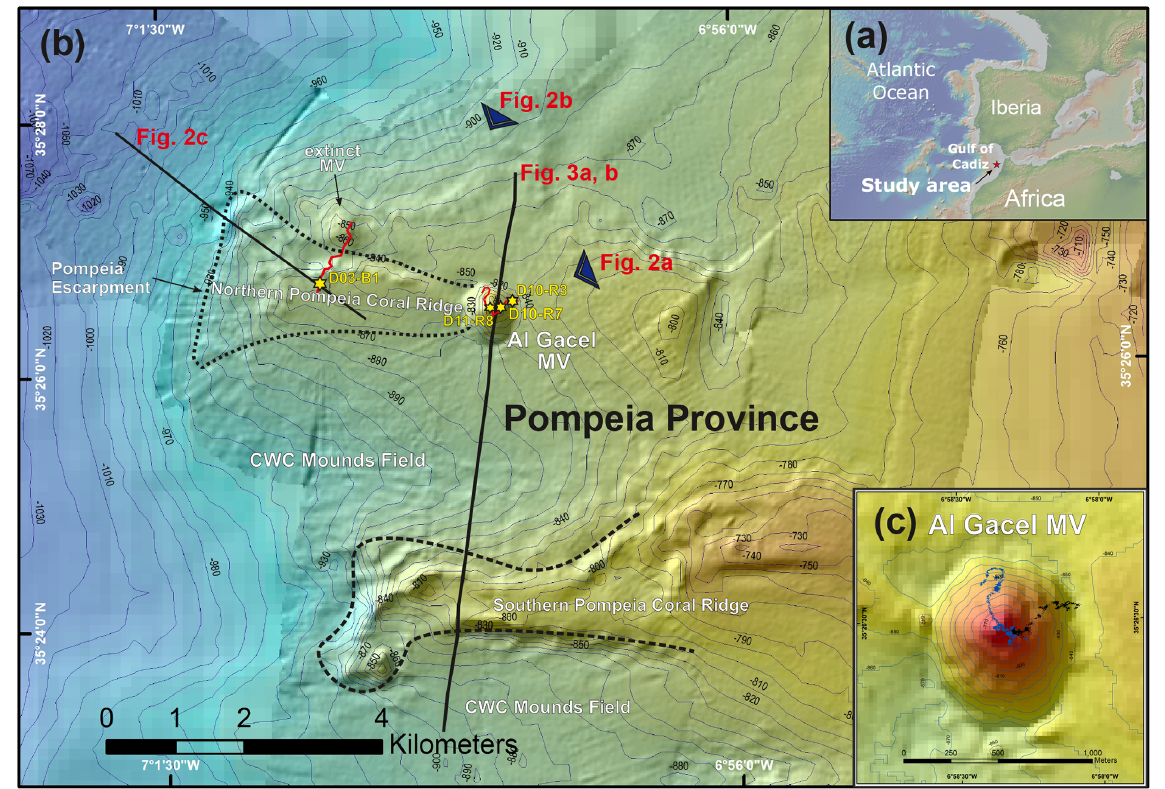
Figure 1. Bathymetric map of the study area. (a) Location of the Gulf of Cádiz between Spain, Portugal and Morocco. The study area is marked with a red star. (b) Pompeia Province including its different morphological features. Red lines indicate remotely operated vehicle (ROV) paths, yellow stars mark sampling sites. (c) Detailed map of the Al Gacel MV including pathways of Dive 10 and 11 (black and blue lines, respectively). Further details of the area are provided in Figs. 2 and